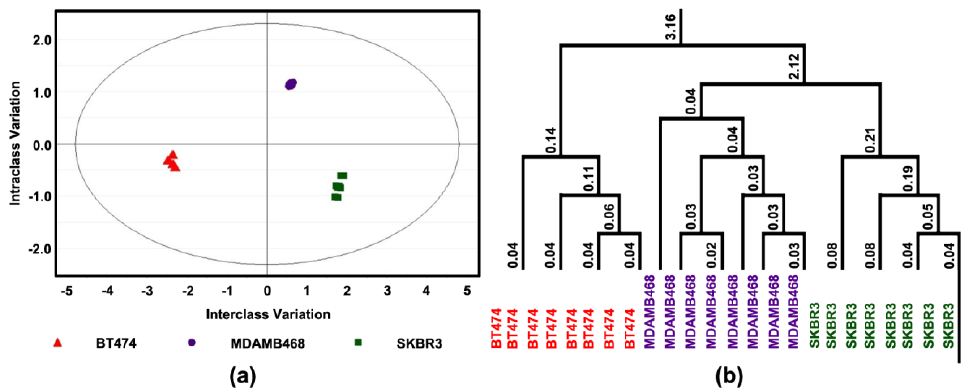
Figure 5. Effect of 4-oxo-DHA on Growth Factor Signaling. Levels of cell proliferation or apoptosis and associated target proteins in three human breast cancer cell lines (BT474, SKBR3, and MDAMB468); ( a ) Orthogonal projections to latent structures-discriminant analysis (OPLS-DA) shows a 3-class supervised model and partition the sources of variation; ( b ) To visualize the misclassification rate, the dendrogram depicts hierarchical clustering patterns among three different cell lines.